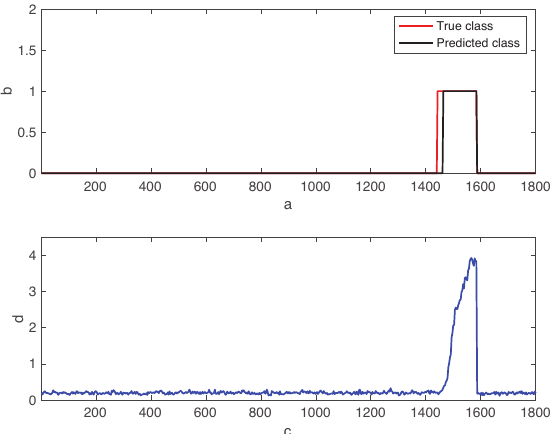
Figure 6. Transient behavior of the fault state and the residual error of the autoencoder. Fault 01 is introduced to the normal state at 1440